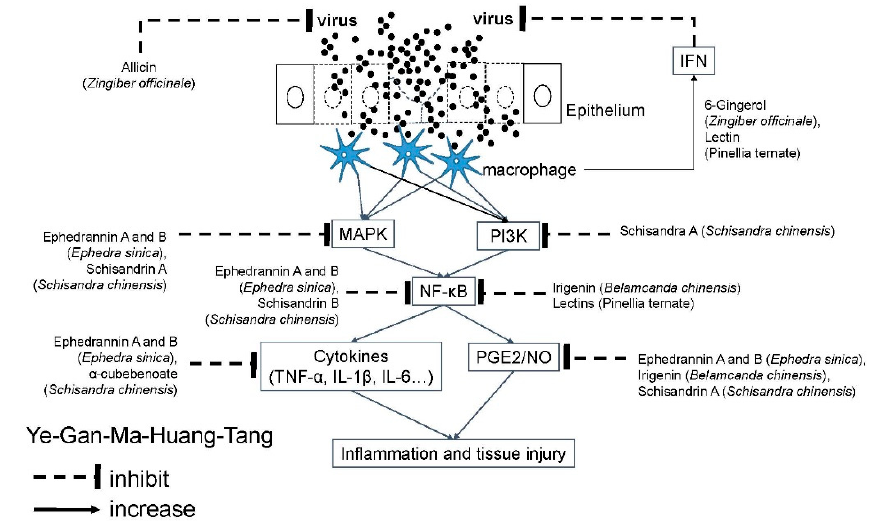
Figure 6. Molecular mechanism of Ye-Gan-Ma-Huang-Tang against airway viral infections. Airway viruses infect the epithelium to cause tissue injury. Ye-Gan-Ma-Huang-Tang contains several active molecules to inhibit viral replication and signal transduction of inflammatory response. Akt: Serine/threonine protein kinase B (PKB); COX: Cyclooxygenase; ERK: Extracellular signal-regulated kinase; IL: interleukin; iNOS: Inducible nitric oxide synthases; JNK: c-Jun N-terminal kinases; MAPK: Mitogen-activated protein kinase; NF- κ B: Nuclear factor-kappa B; NO: Nitric oxide; PG: prostaglandin; PI3K: Phosphoinositide 3-kinase; PMN: Polymorphonuclear neutrophils; TNF: Tumor necrotic factor.